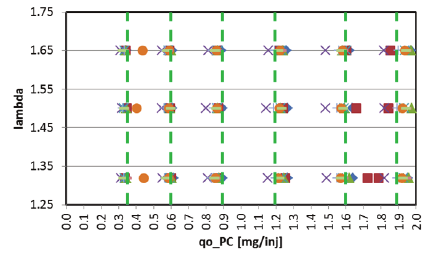
Fig. 8. Adoption of fixed fuel dose values qo_PC